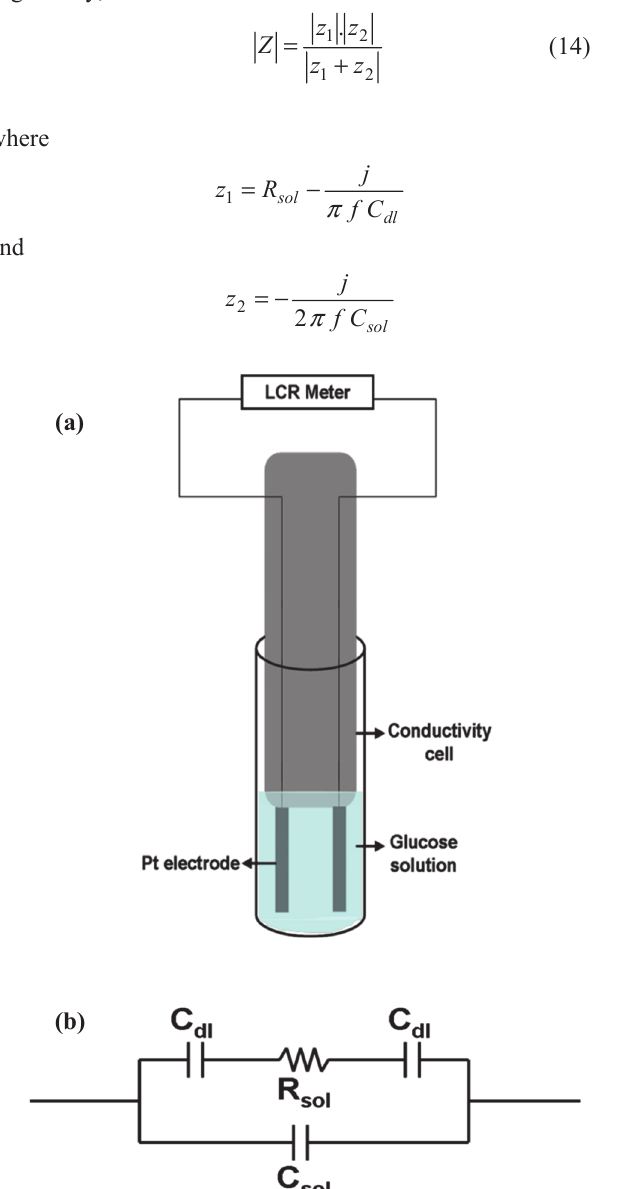
Fig. 2: (a) Schematic diagram of the conductivity cell inside the test tube containing the solution of DI water and glucose; (b) Equivalent circuit of the